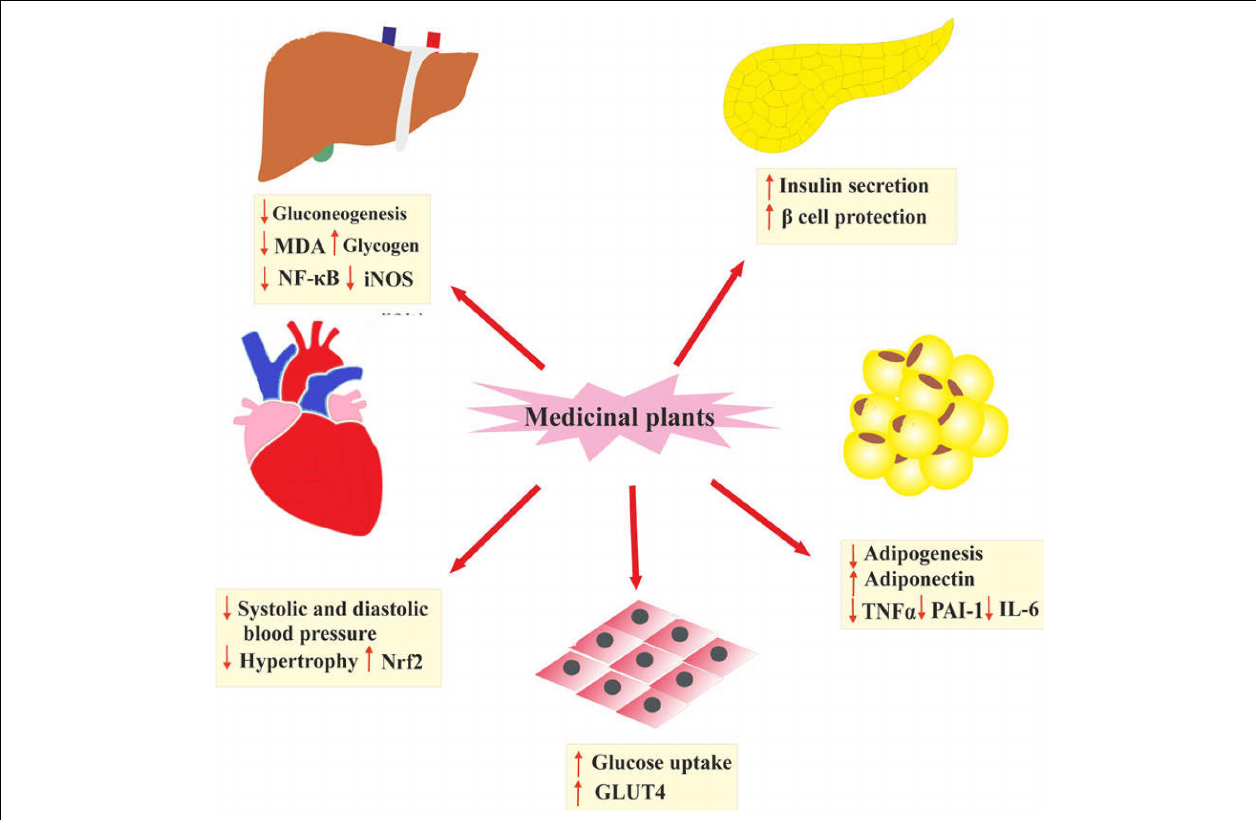
FIGURE 2 | The main mechanisms of medicinal plants for managing MetS. Nrf2, nuclear factor erythroid 2–related factor 2; GLUT4, glucose transporter type 4; TNF α , tumor necrosis factor; PAI-1, plasminogen activator inhibitor-1; IL-6, Interleukin 6; MDA, malondialdehyde; NF- κ B, nuclear factor- κ B; iNOS, inducible nitric oxide